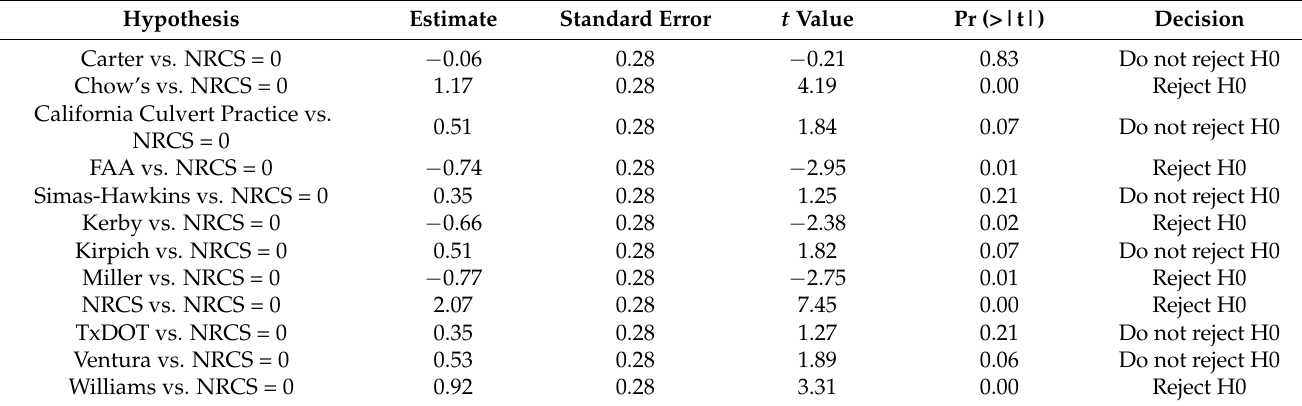
Table 6. Comparison of means using the Dunnett